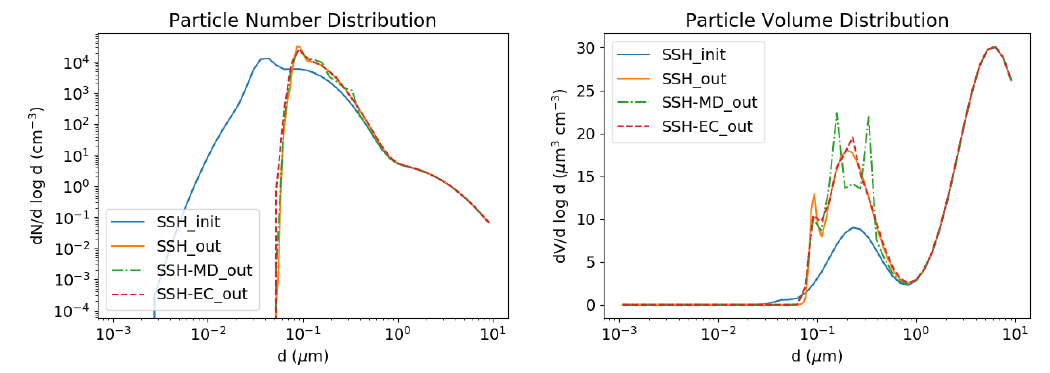
Figure 3. Condensation test case with moving diameter (in green), Euler-coupled (in red) redistributions and no redistribution (in orange). Initial concentrations are in blue. Number ( left ) and volume ( right )